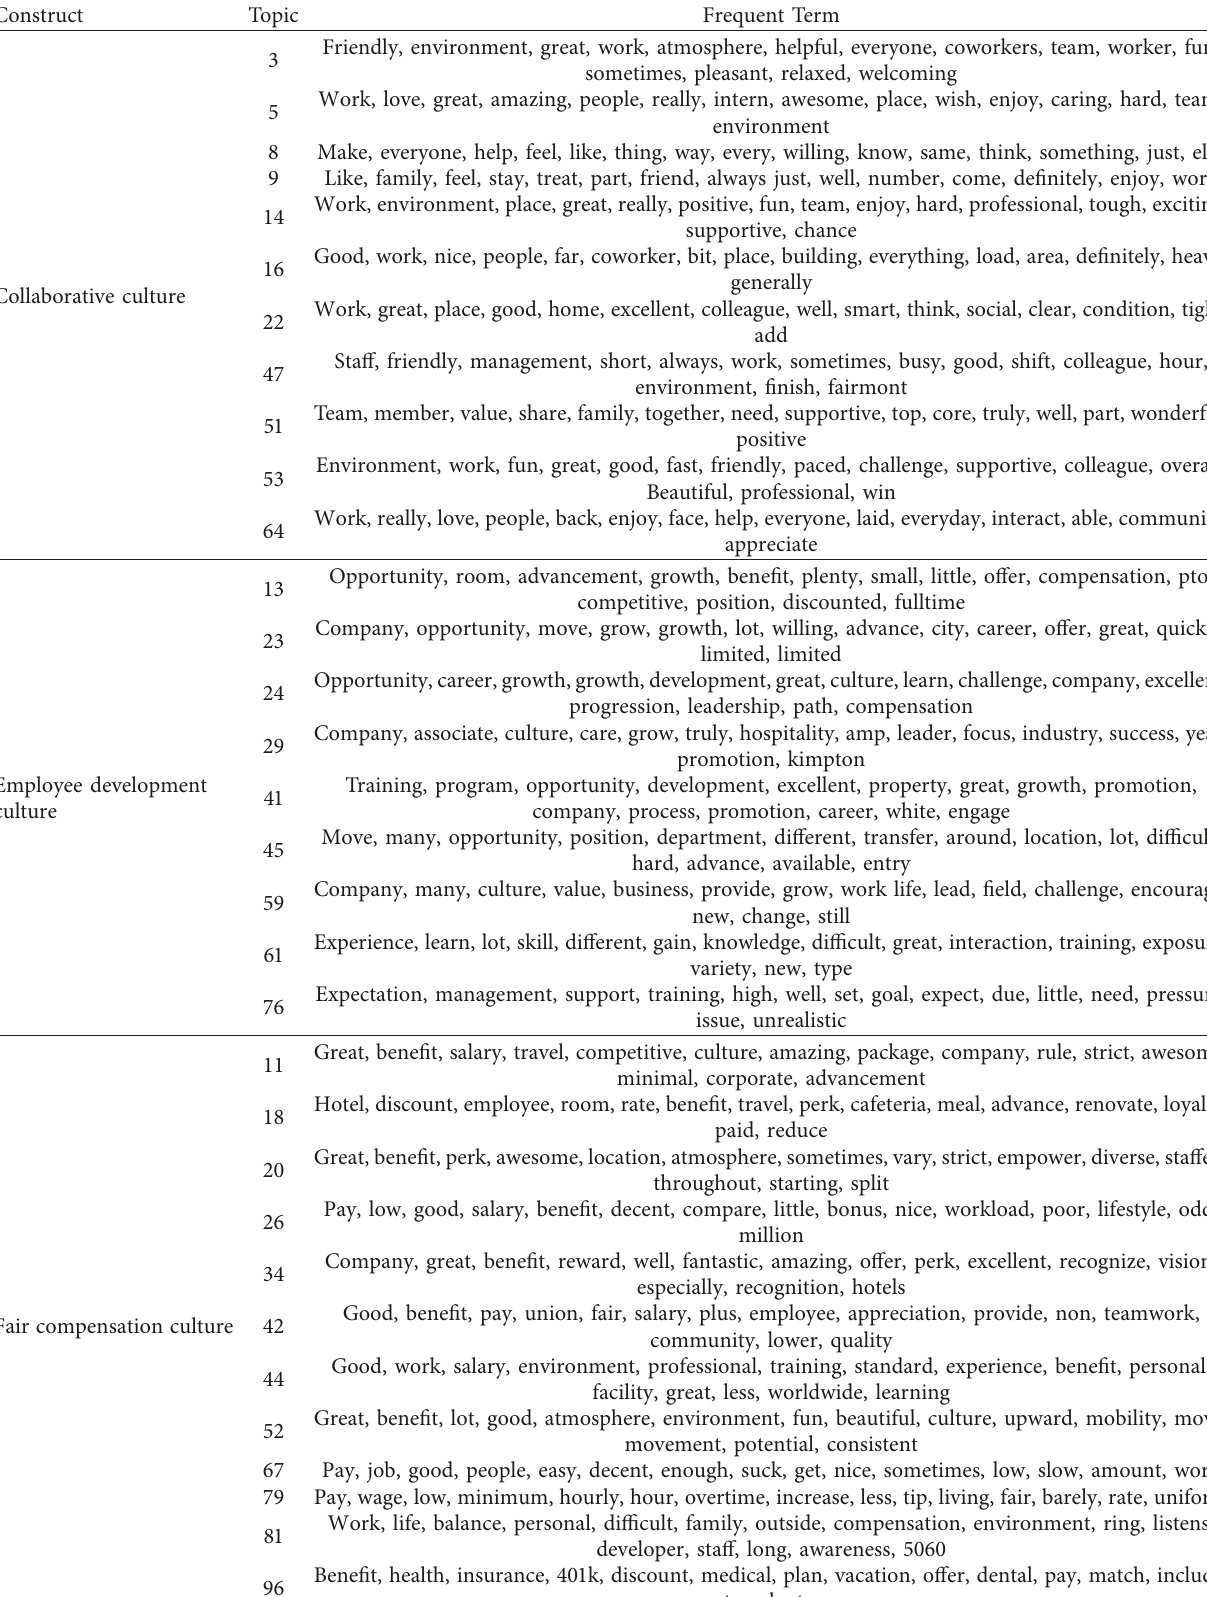
Table 1: Construct measurement by topics generated by